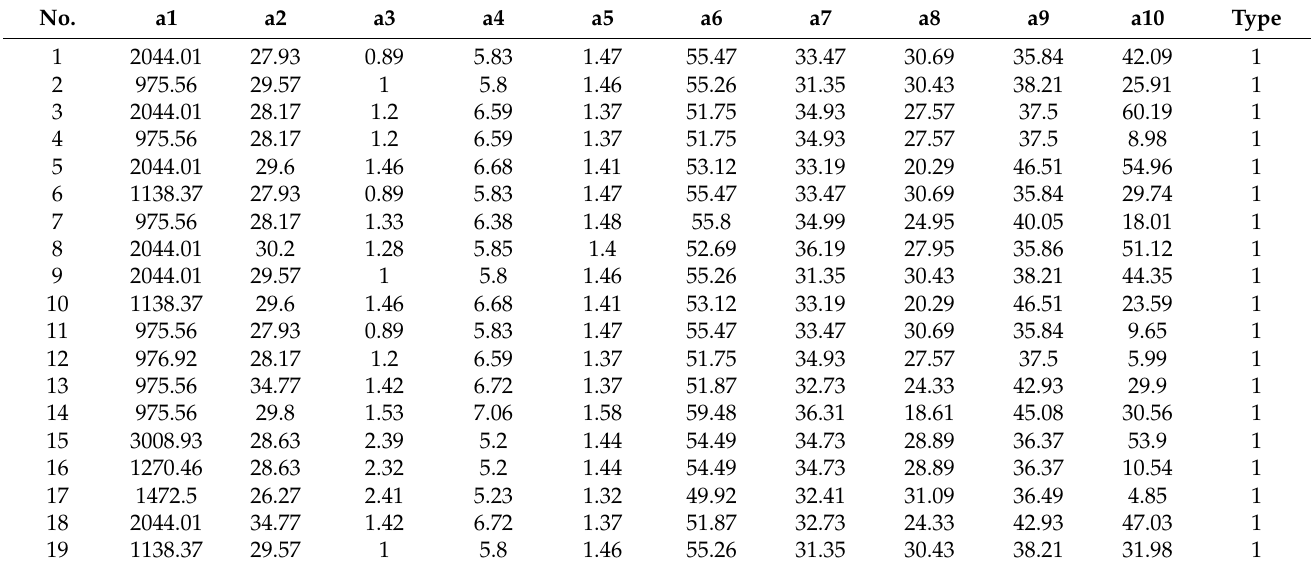
Table A1. Soil erosion